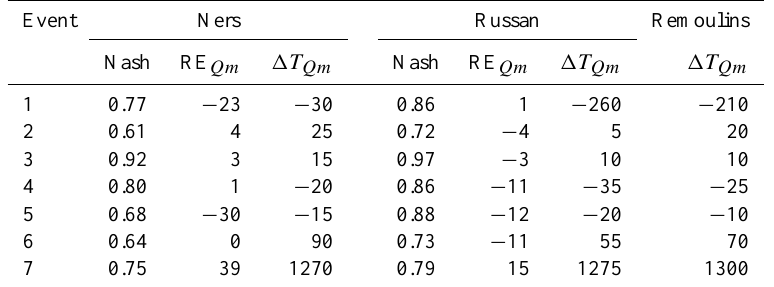
Table 6. Coupling results. Performance indexes at the Ners, Russan and Remoulins stations. At Remoulins, only the 1T Qm index was calculted, the rating curve being very uncertain. Event Ners Russan